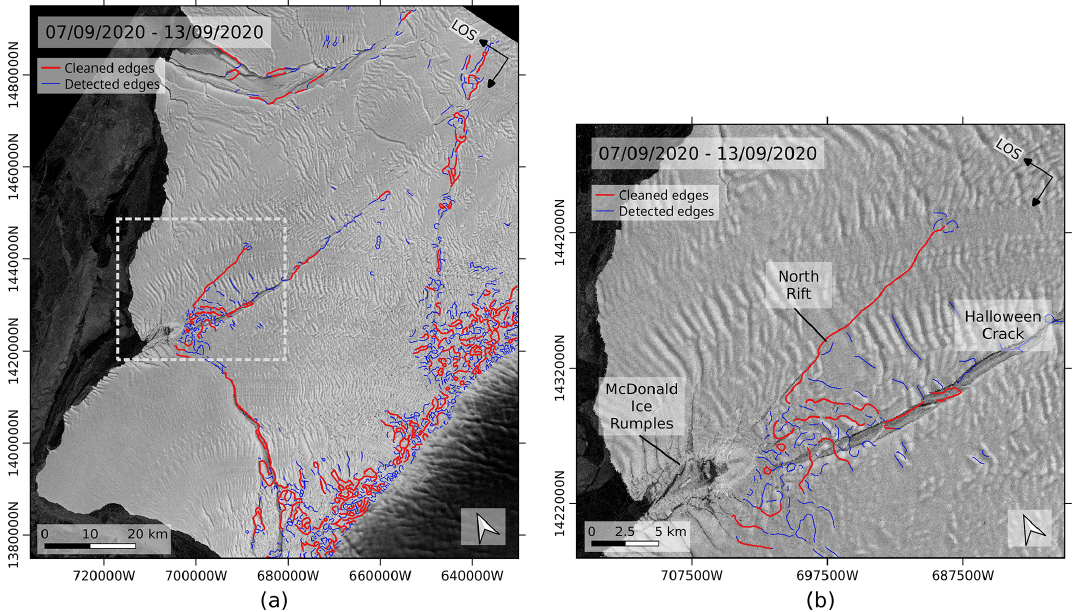
Figure 5. Cracks automatically delineated from the interferogram of 7–13 September 2020. (a) Edge detection results, before (blue) and after cleaning (red) of the small dangles. The Canny edge detection applied to the phase gradient magnitude shown in Fig. 4. (b) Close-up view of (a) , whose extent is indicated by the grey dashed frame.